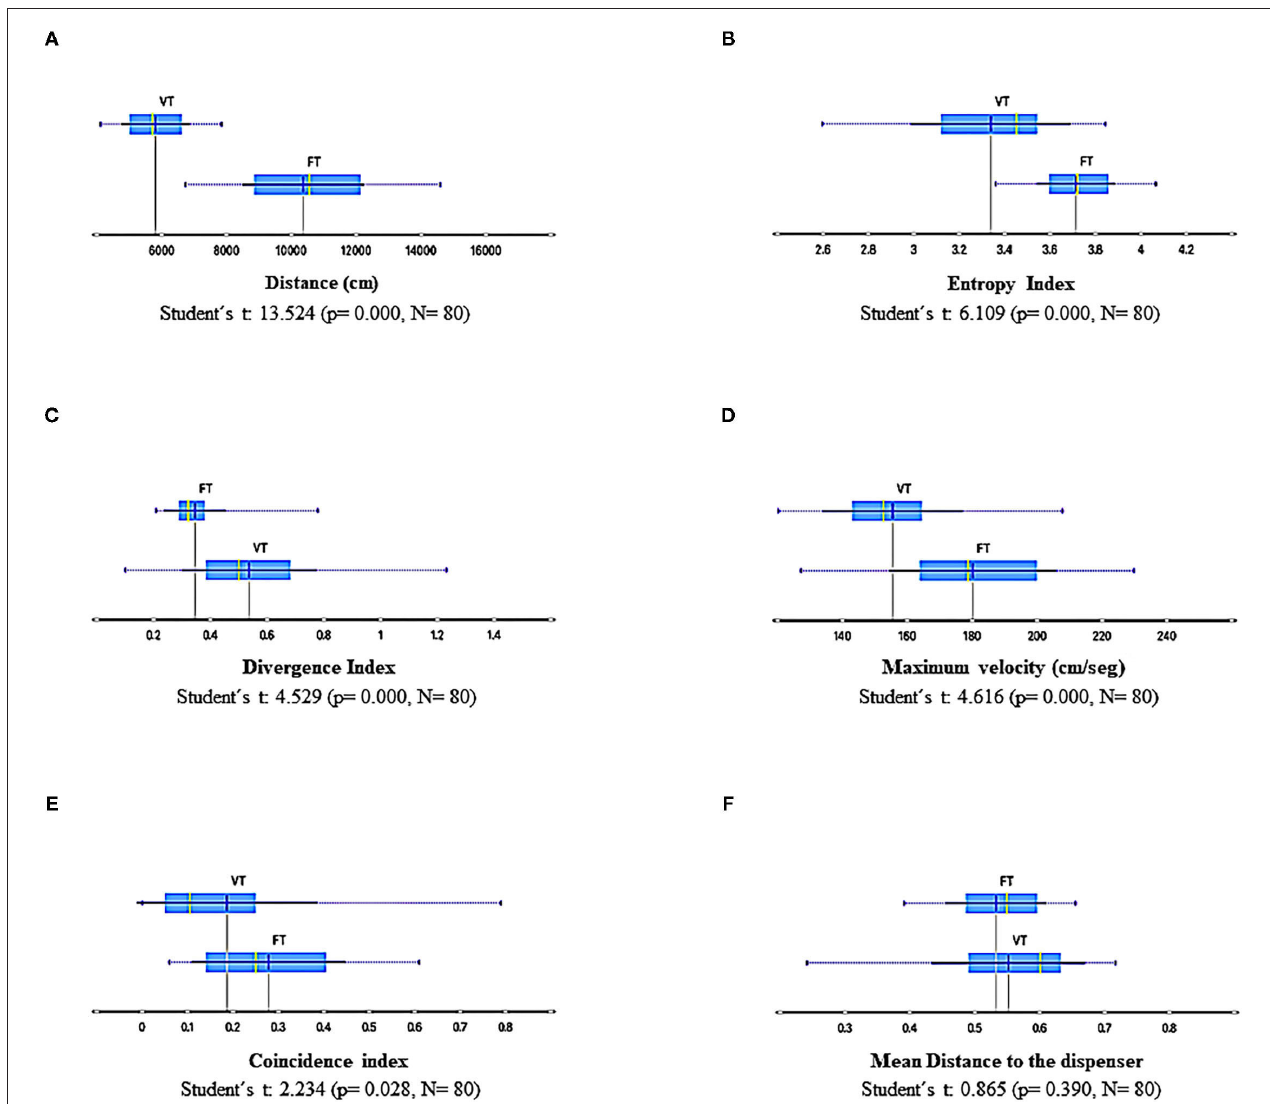
FIGURE 4 | Summary results of spatial-behavior measures for all sessions and subjects under FT and VT schedules. (A) , traveled distance per session; (B) , entropy; (C) divergence; (D) , maximum velocity per session; (E) , coincidence index; and (F) mean distance to the dispenser. Each box depicts the mean (dark blue vertical line), the median (yellow vertical line), the standard deviation (thin blue line), and the values between the first and the third quartile (blue highlighted area).